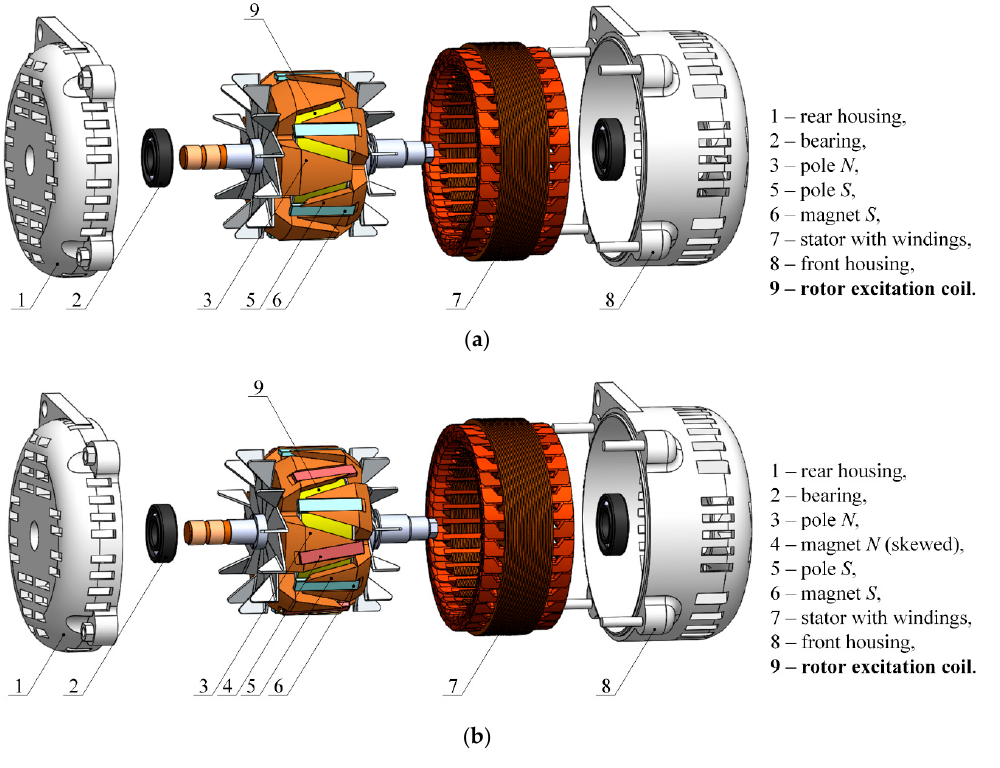
Figure 16. Visualization of a claw pole machine: ( a ) With permanent magnets on one part of the rotor [56]; ( b ) With permanent magnets on both parts of the rotor